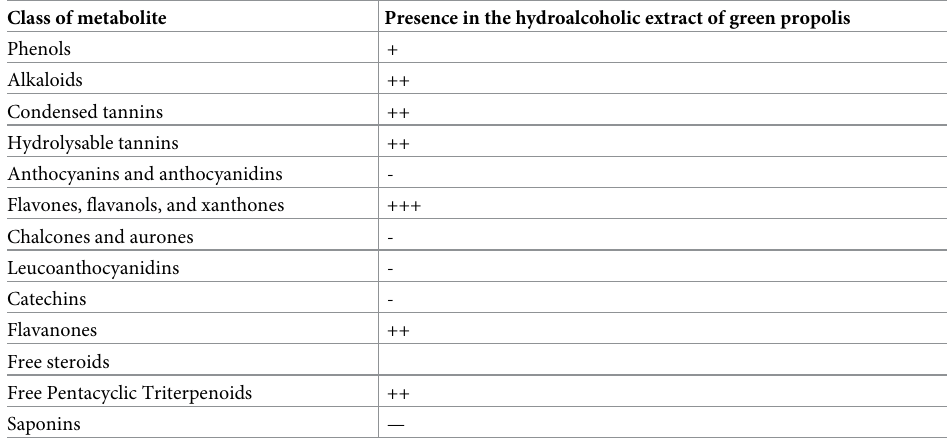
Table 2. Classes of secondary metabolites identified in green propolis extract.